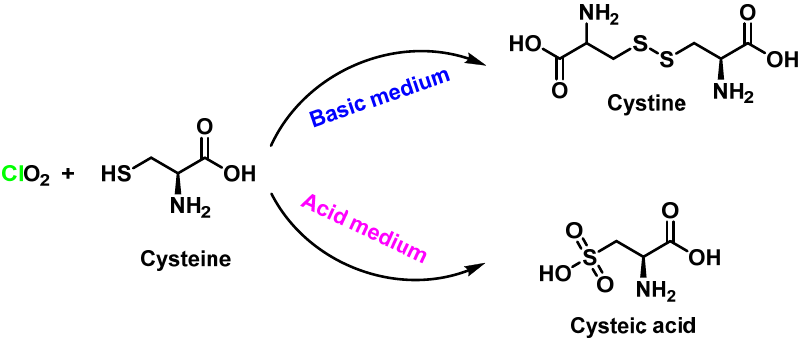
Figure 36. At acidic pH, cysteine sulfonic acid was produced. At alkaline pH, cystine was obtained.